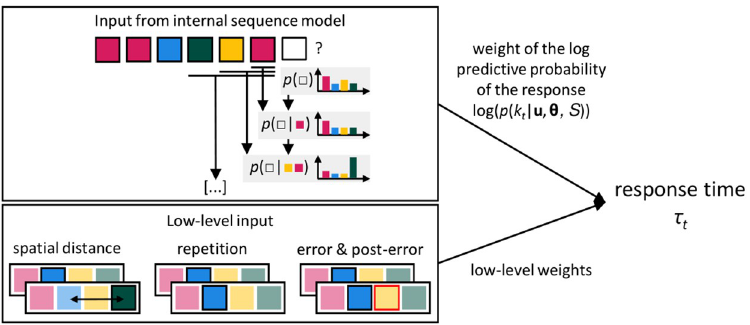
response repetition, error and post-error trials; lower box) to participants’ response times. The contribution of the sequence model is the scaled log of the predictive probability of each key press k (one of the four keys, marked as transparent square), given the context u (previous events, marked as a string of colored squares). The sequence model makes predictions by flexibly combining information from deepening windows onto the past, considering fewer or more previous